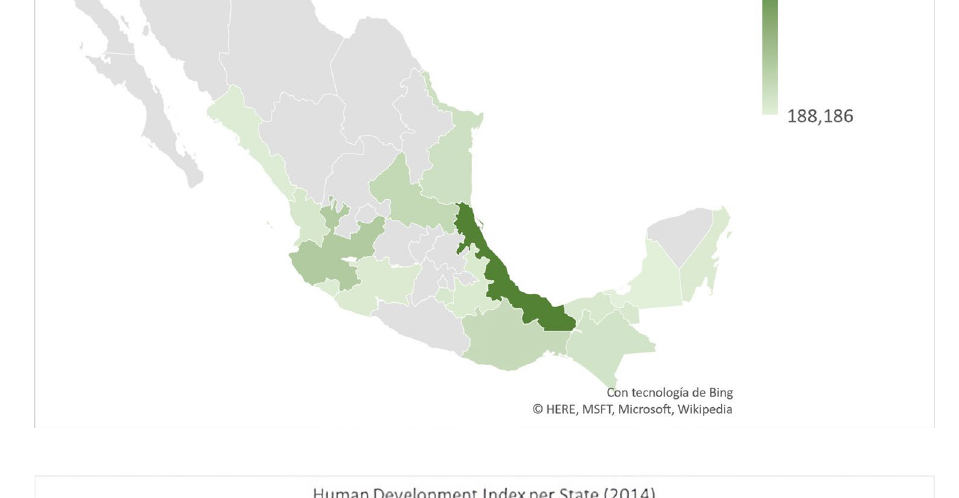
Fig. 7 Mexico’s Human Development Index for